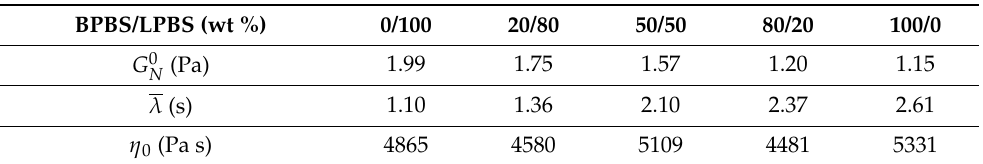
Table 7. Plateau modulus G N 0 , mean relaxation time λ , and the zero-shear rate viscosity η 0 of BPBS, LPBS, and their blends at 150 ◦